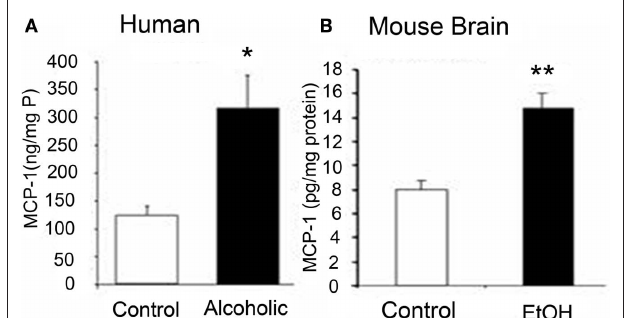
Figure 2 | Comparisons of increased levels of CCL2 in post-mortem human alcoholic brain and mouse brain following chronic ethanol treatment. Shown is data from different studies within our laboratory illustrating increased levels of the chemokine MCP-1 (CCL2) in humans and mice following ethanol exposure. (A) MCP-1 protein levels from human hippocampal homogenate measured using ELISA. Increased MCP-1 levels were also found in ventral tegmental area, substantia nigra, and amygdala (see He and Crews, 2008). (B) Levels of MCP-1 in mouse brain increased following chronic ethanol treatment. Mice (C57Bl/6) treated with 10 daily doses of ethanol (5.0 g/kg. i.g.) and brain MCP-1 levels were determined 24 h after the last ethanol administration (see Qin et al., 2008 for details). These studies indicate that ethanol upregulates the innate immune chemokine MCP-1 in post-mortem human alcoholic and mouse brain samples, which is consistent with ethanol activation of innate immune